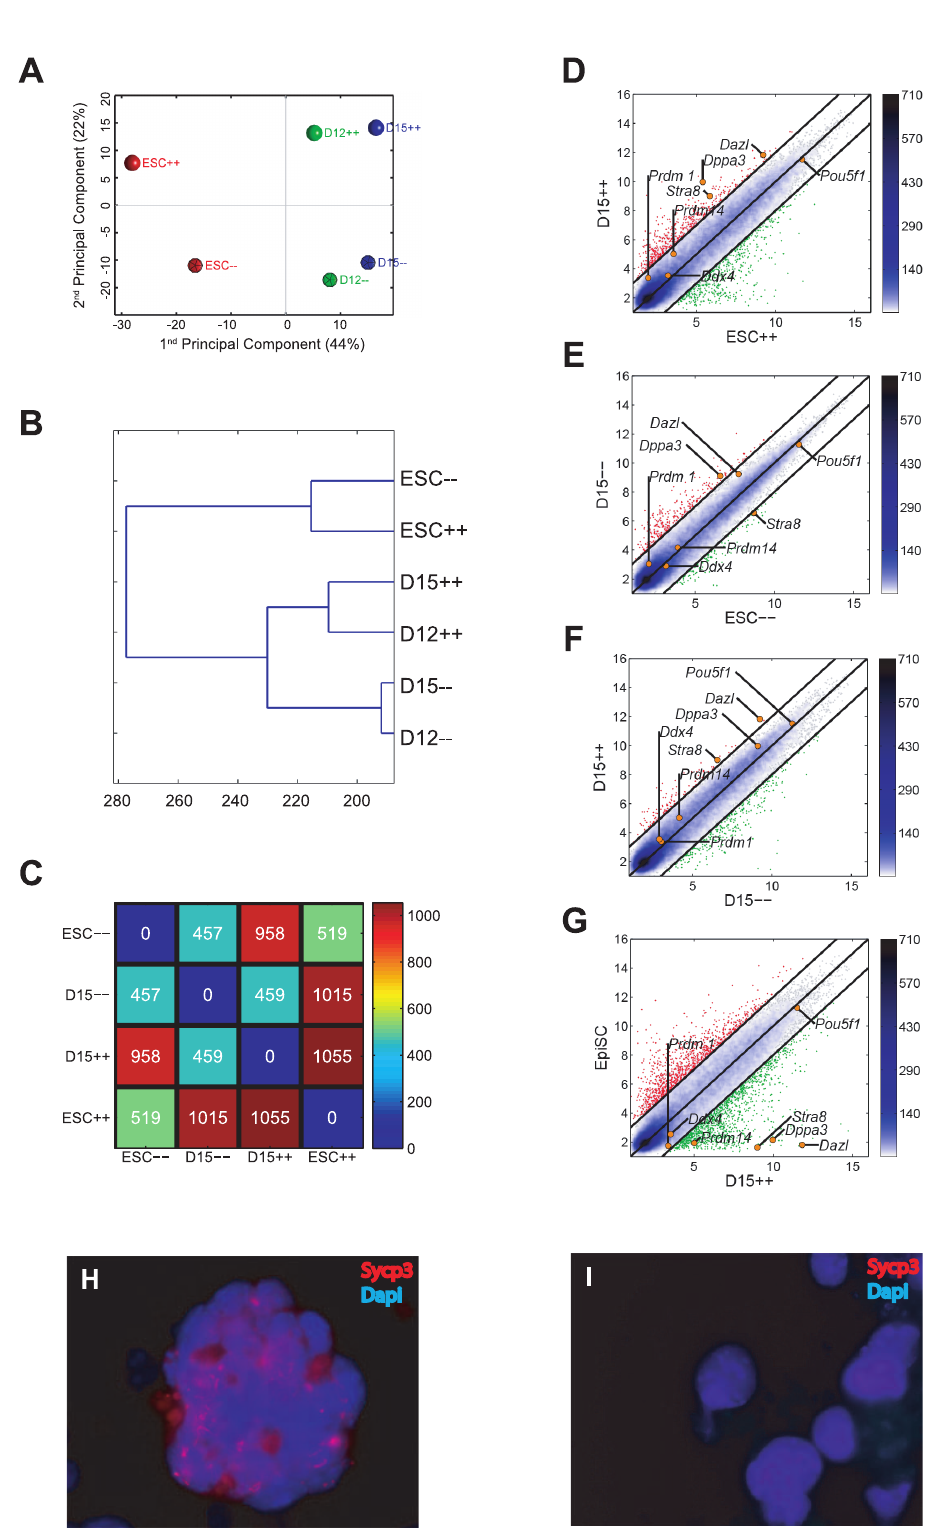
Figure 4. Global gene expression of Oct4-GFP( D PE) ESC-derived PGCs and Gcnf -deficient ESC-derived PGCs compared with wt ESCs. ( A ) Bi-dimensional PCA. The first principal component (PC1) captures 44% of the gene expression variability and the second principal component (PC2) captures 22%. ( B ) Hierarchical clustering. D denotes days, ++ denotes the wt, and 2 denotes the mutant groups. ( C ) Map of distances between samples (using as a metric the number of differentially expressed genes with fold change in log 2 scale higher than two). The color bar to the right gives the color codification of the distances—the closer the two samples, the darker the blue color; the further the two samples, the darker the red color. ( D–G ) Pair-wise scatter plots of global gene expression in ESCs vs. in vitro –derived PGCs. Black lines indicate the boundaries of the two-fold changes in gene expression levels between the paired cell types. Color bar to the right indicates the scattering density—the higher the